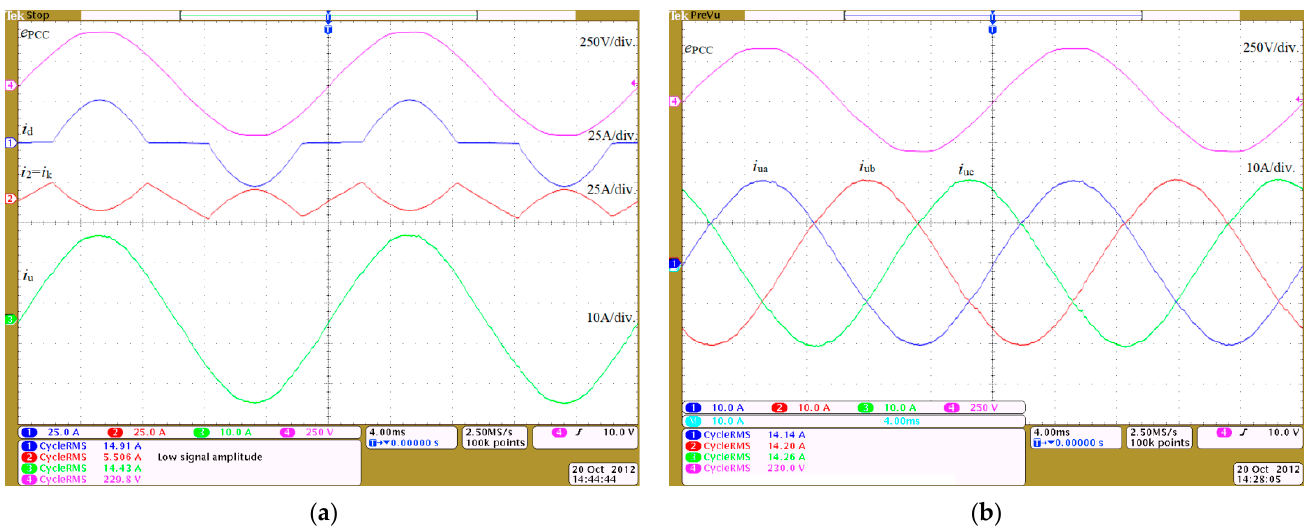
Figure 6. Oscillograms of the following waveforms: ( a ) from the top: voltage in the PCC, downstream current, APF current, upstream current in the PCC; ( b ) from the top: voltage in the PCC, three phases of the upstream current in the PCC.